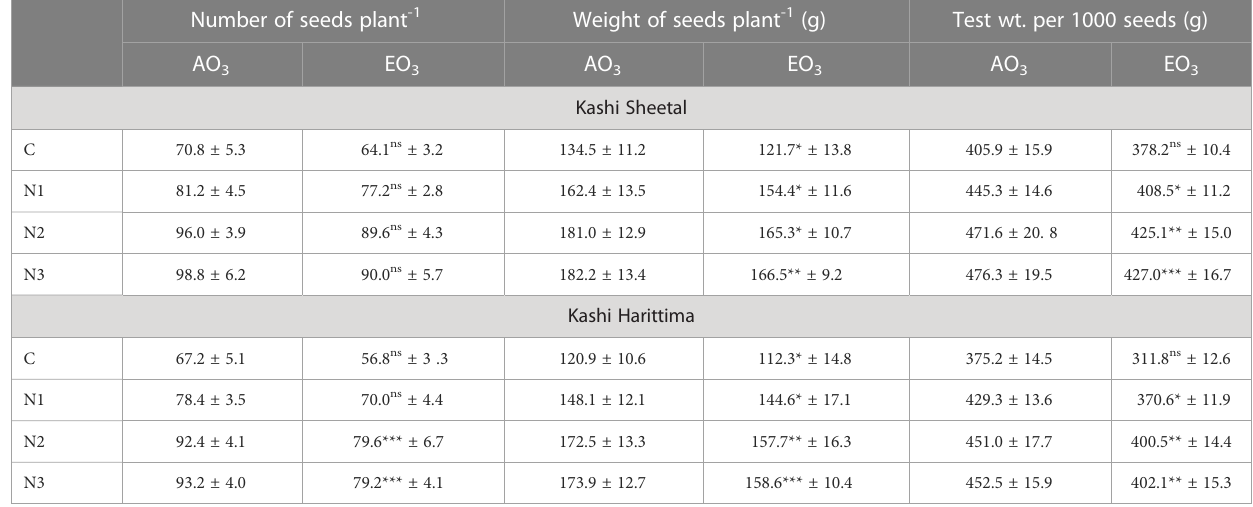
TABLE 4 Variations in the number of seeds plant -1 , wt. of seeds plant -1 , and test wt. per 1000 seeds of both varieties of Dolichos lablab L. grown under AO